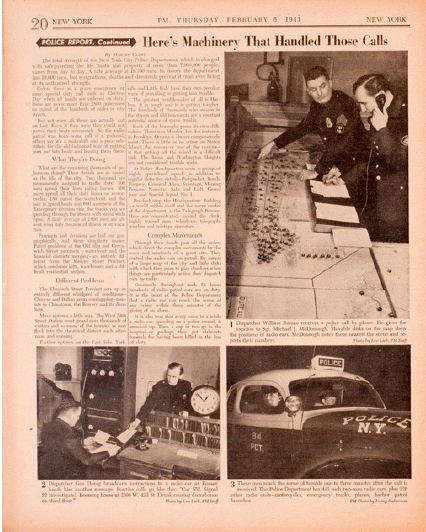
Figure 12. “Police Report: Here’s the Machinery That Handled Those Calls”, PM , 6 February 1941. Image courtesy of the International Center of Photography.